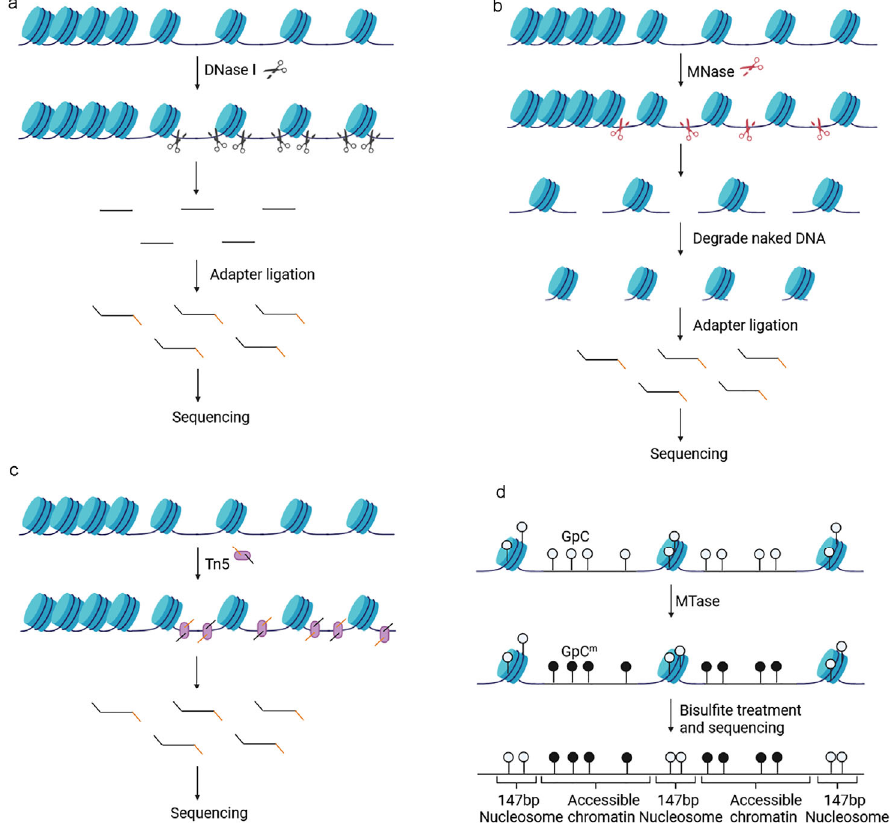
Figure 2. Schematic diagram of DNase-seq, MNase-seq, ATAC-seq, and Nome-seq. ( a ) DNase-seq cleaves accessible chromatin regions characterized by DHSs with DNase I; ( b ) MNase-seq uses MNase to cleave inter-nucleosomal DNA and to degrade the naked accessible DNA; ( c ) ATAC-seq uses Tn5 transposase to ligate sequencing adaptors while cutting DNA fragment; ( d ) Nome-seq uses M.CviPI GpC methyltransferase (MTase) to methylate GpC in accessible chromatin to GpCm, and bisulfite treatment can distinguish GpC from GpCm.